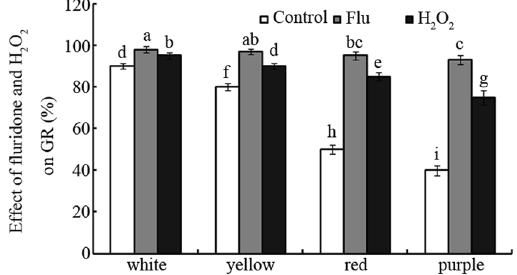
Figure 3. Effects of fluridone and H 2 O 2 on GR Effects of fluridone and H 2 O 2 on seed GRs of maize. Bars represent standard deviations of means ( n = 5), and means followed by the same letter are not significantly different ( p < 0.05) among treatments. Flu, fluridone; H 2 O 2 , hydrogen peroxide; GR, germination